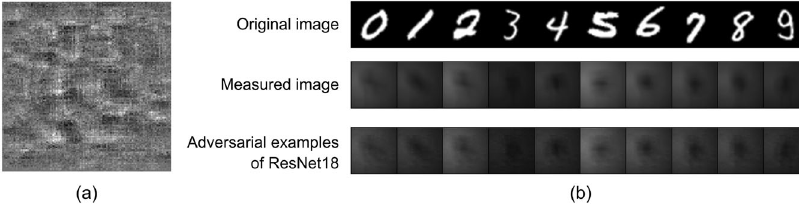
Fig. 6 A universal wall perturbation on the secondary surface. a Learned universal wall perturbation on the secondary surface. Note that the perturbation has been ampli fi ed for visualization purposes only. b Adversarial examples are generated with the